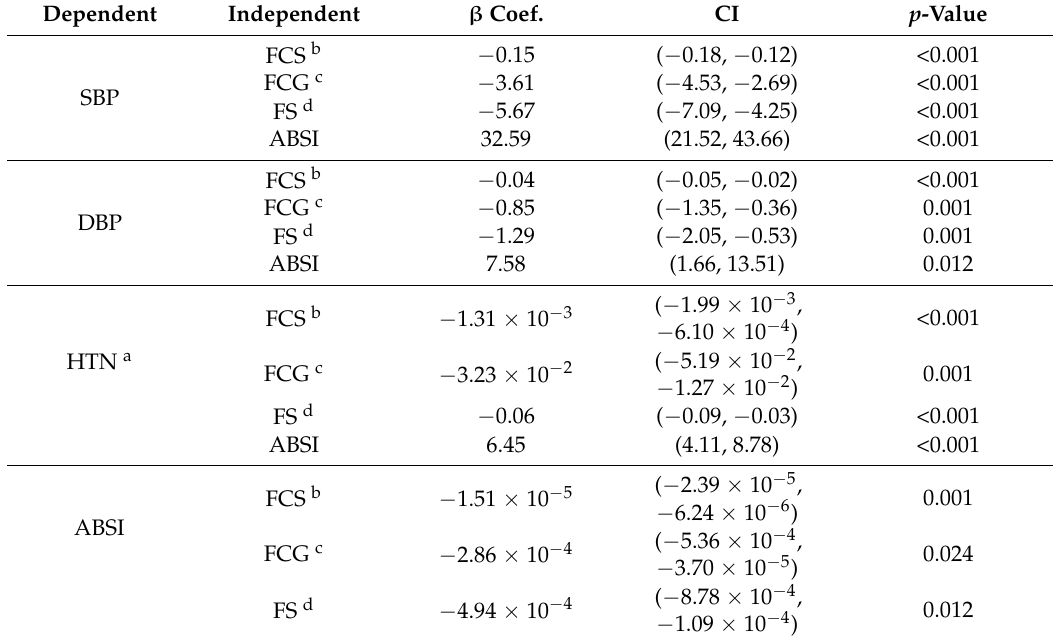
Table 3. General estimating equations (GEE) result between food security, ABSI, and hypertension.